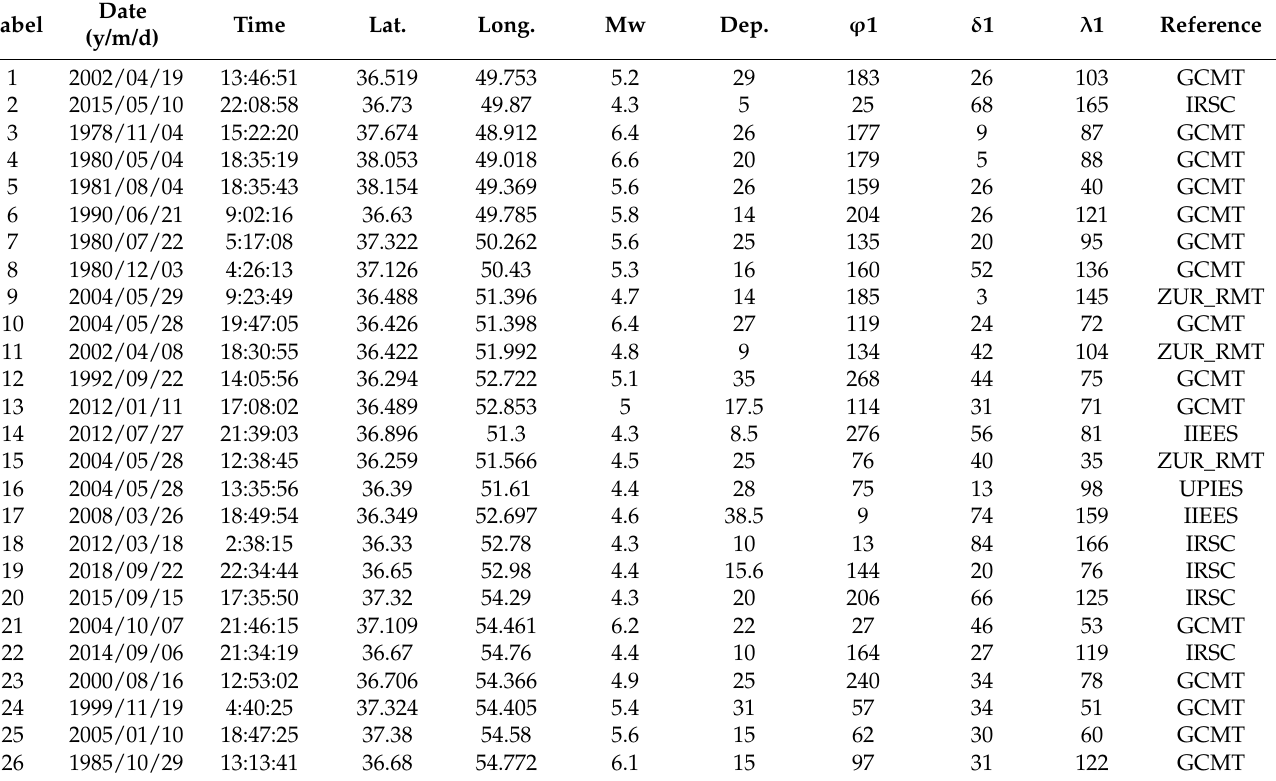
Table 1. Parameters of the earthquake source are applied to calculate the seismic strain rate ( ϕ , δ , and λ symbols represent strike, dip, and rake angles of the preferred nodal planes, respectively). The first column label refers to the focal mechanisms in Figure 2. Lat. and Long. refer to EHB (Engdahl bulletin), IIEES (International Institute of Earthquake Engineering and Seismology), and IRSC (Iranian Seismological Center). Abbreviations of References label: GCMT (Global Centroid Moment Tensor); ISC (Instrumental Earthquake Catalogue); ZUR_RMT (Zurich Moment Tensors); UPIES (moment tensors, University of Potsdam,